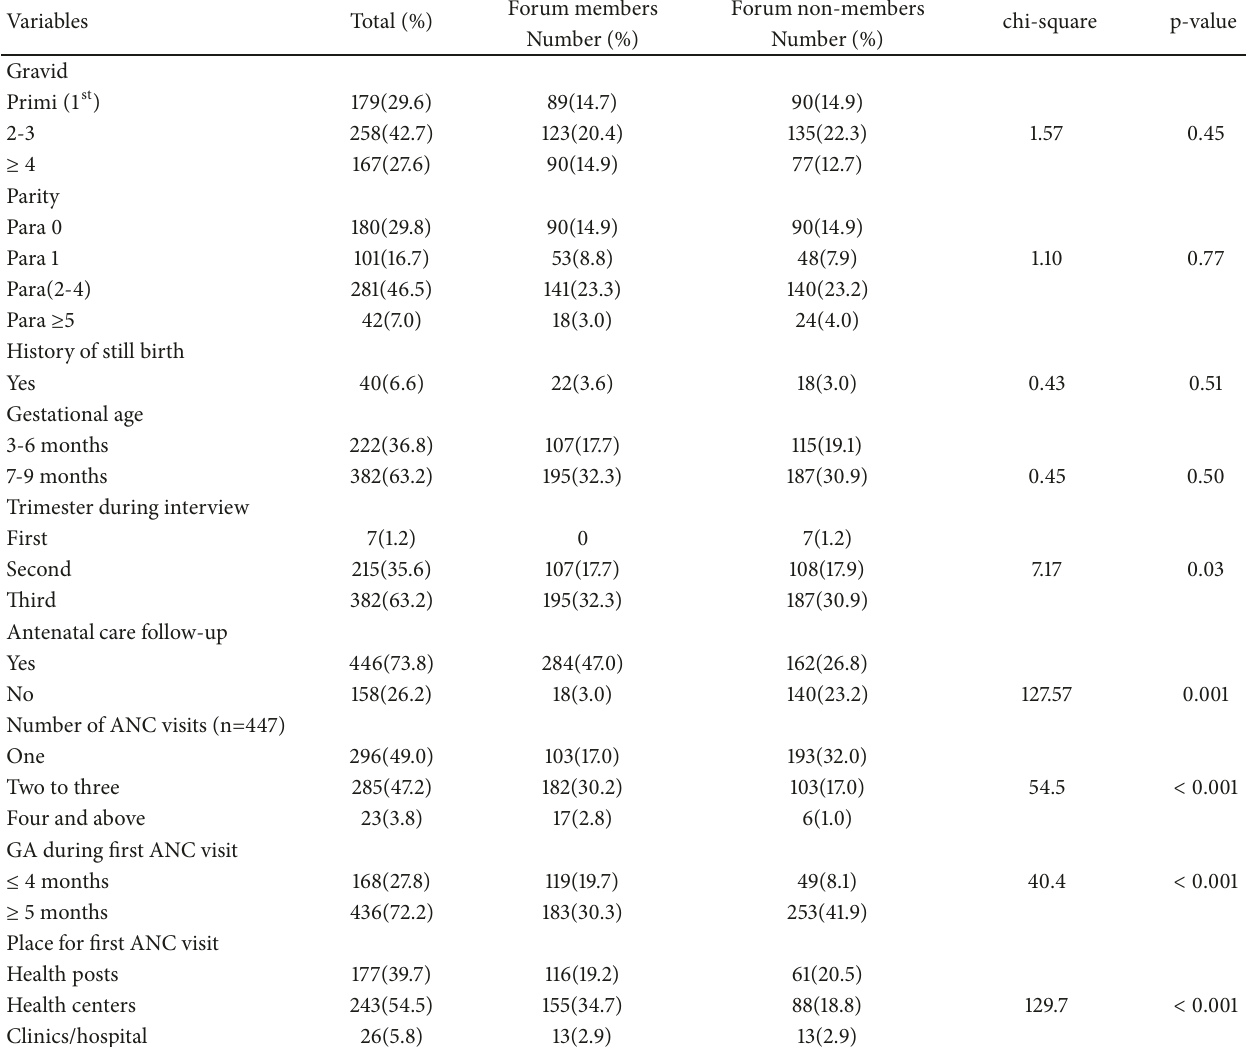
Table 2: Obstetric history and antenatal care experience of the respondents in Dale Woreda,